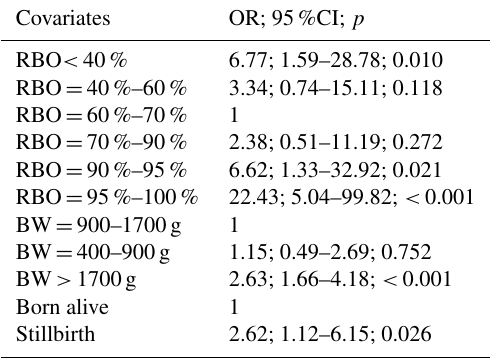
Table 3. Multivariate analysis of risk factors for dystocia in swine at piglet level ( n =